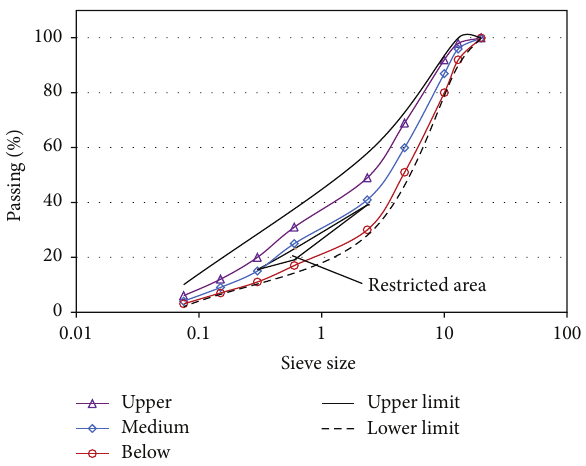
Figure 1: Aggregate gradations in 0.45 power.